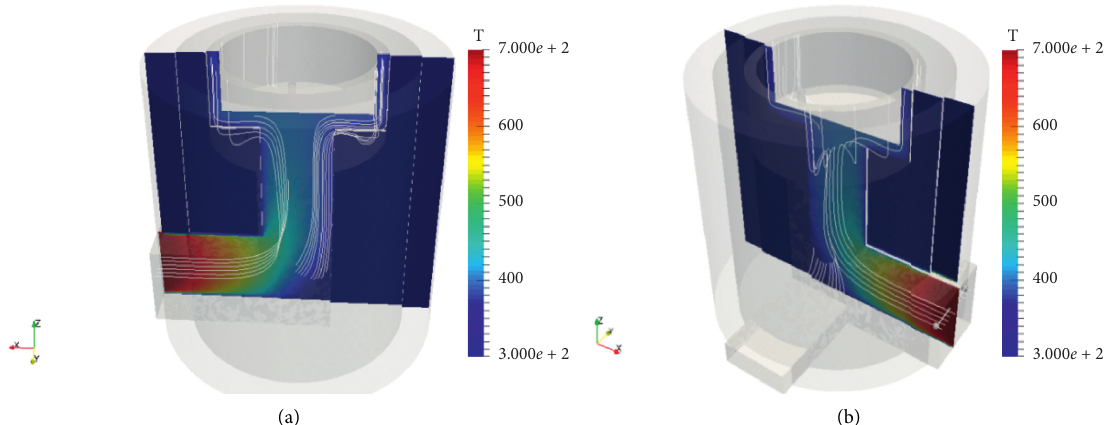
Figure 10: Temperature contours for stove with insulations of (a) clay-sawdust and (b) sawdust alone.